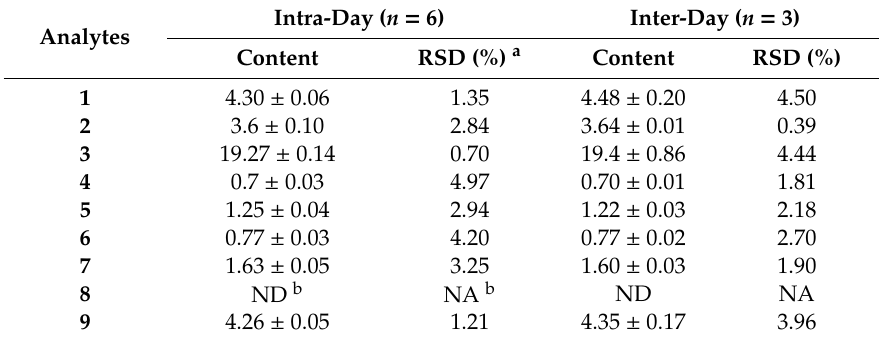
Table 3. Intra- and inter- day repeatability for determination of nine triterpenoids in P. guajava.